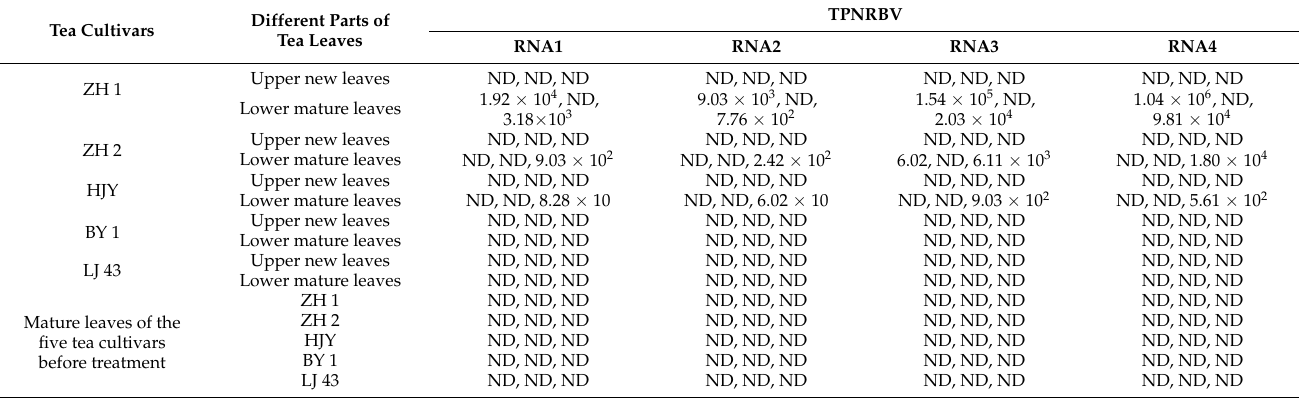
Table 2. Detection of TPNRBV in five tea cultivars exposed to TPNRBV-diseased ‘BY 1’ gardens